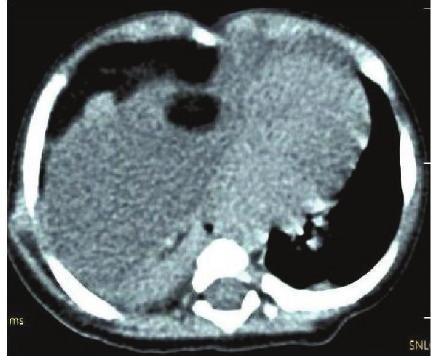
Figure 4: Histopathological features of the